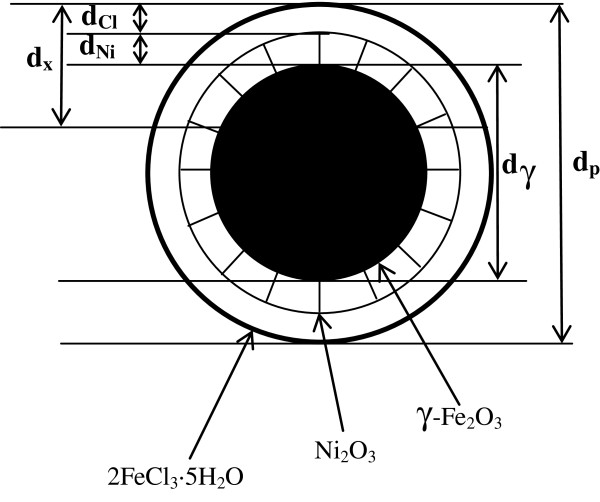
The schematic cross-section of the particle detected by XPS for the samples (1), (2), (3) and (4). Note: dx<12dp.